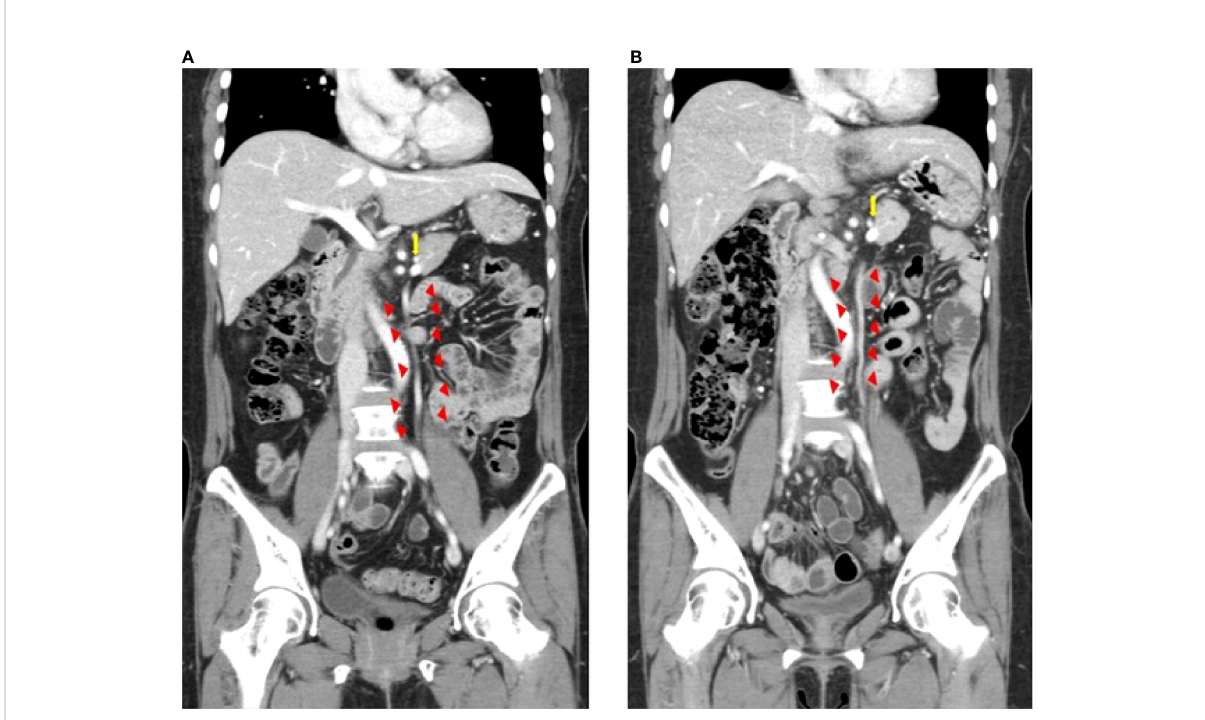
FIGURE 3 Inferior mesenteric vein preservation con fi rmed on computed tomography images before (A) and after surgery (B) Triangles indicate the inferior mesenteric vein. The arrow indicates the splenic